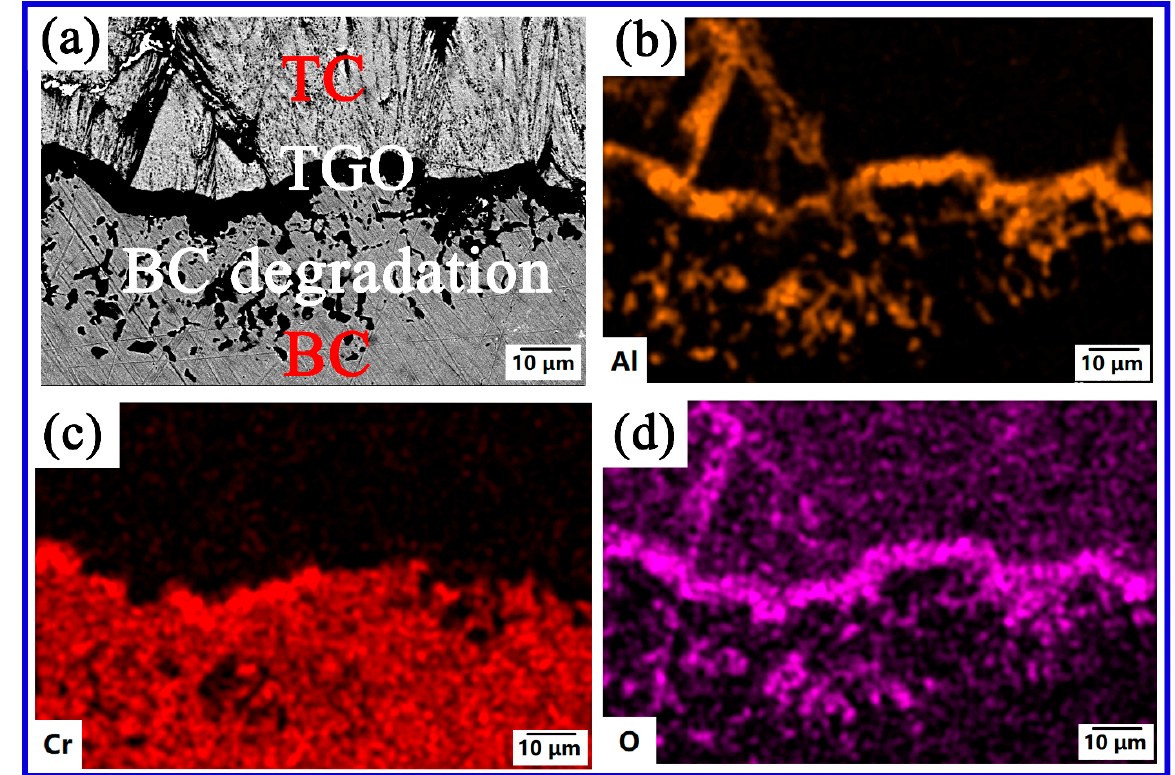
Figure 11. ( a ) The cross-sectional morphologies of YSZ coating treated with NaCl on the degraded part of the bond coating. ( b – d ) corresponding EDS maps of cracks ( a ).